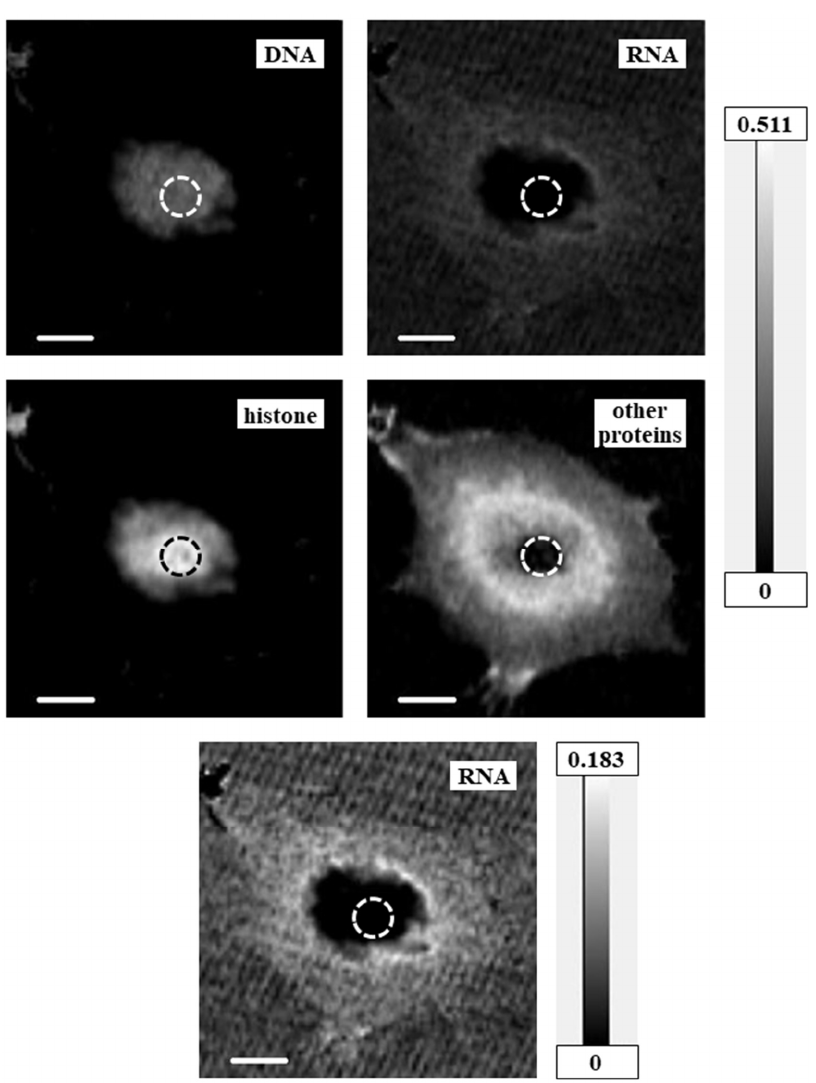
Figure 5. Mass thickness images for DNA, RNA, histone, and proteins other than histone of the CHO cell. The top four images use the same grayscale (in units of pg/ µ m 2 ) for comparison of each level. Bottom image shows the distribution of RNA with a different grayscale (pg/ µ m 2 ) for clarity. Scale bars = 5 µ m. Areas possibly unreliable for analysis are encircled by dashed lines.